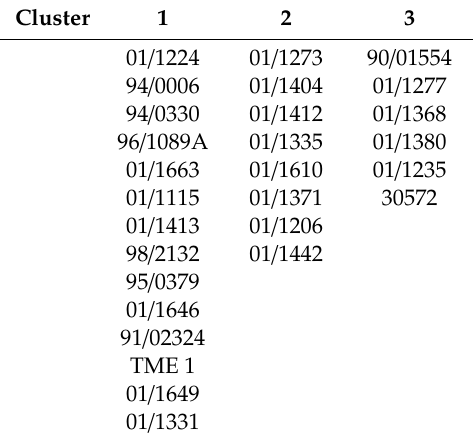
Table7. Clusteranalysisofyellow-fleshedcassavarootsacrossallgrowinglocationsusingallparameters Cluster 1 2 3 01 /